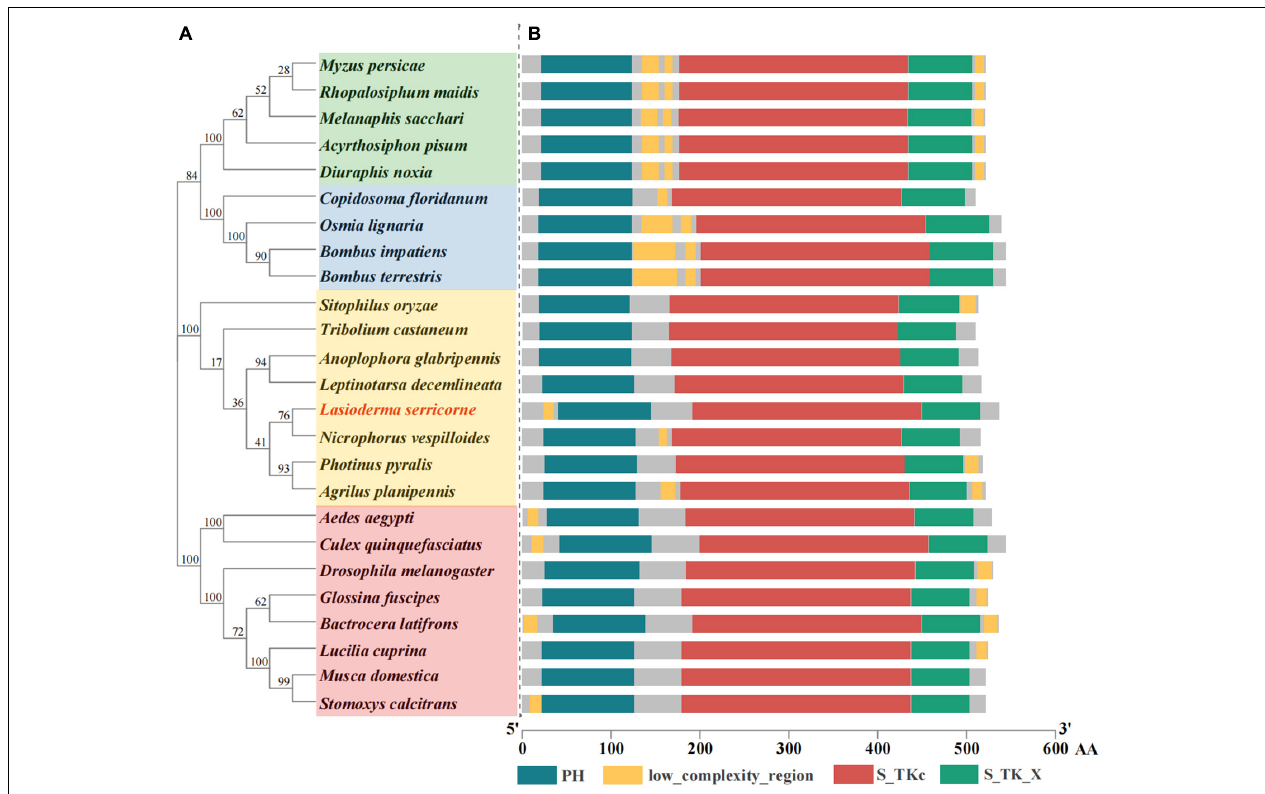
FIGURE 1 | Phylogenetic analysis and protein structure comparison of insect Akts. (A) Phylogenetic tree generated with MEGA 7 by using neighbor-joining method with 1000 bootstrap replications. The GenBank accession numbers are listed in Supplementary Table 2 . (B) Schematic alignment and comparison of domain architecture of insect Akts. AA, amino acids; PH, pleckstrin homology; S_TKc, catalytic domain; S_TK_X, the extension to serine/threonine-protein